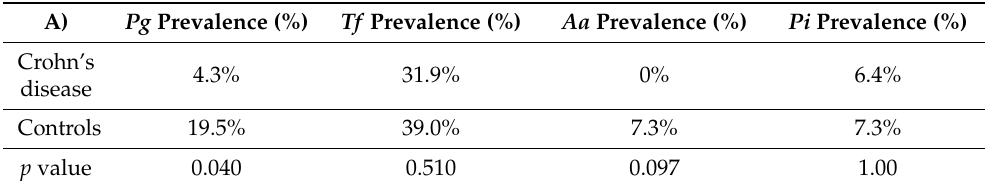
Table 1. Salivary carriage of P. gingivalis (Pg), T. forsythia (Tf), A. actinomycetemcomitans (Aa), or P. intermedia (Pi) in Crohn’s disease and control